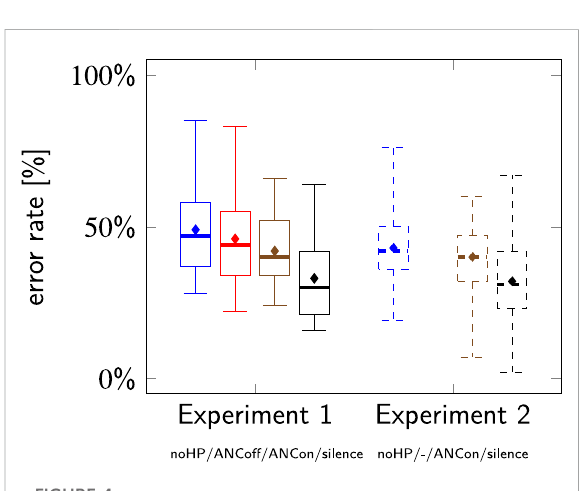
FIGURE 4 Boxplots, showing the error rates of the serial recall